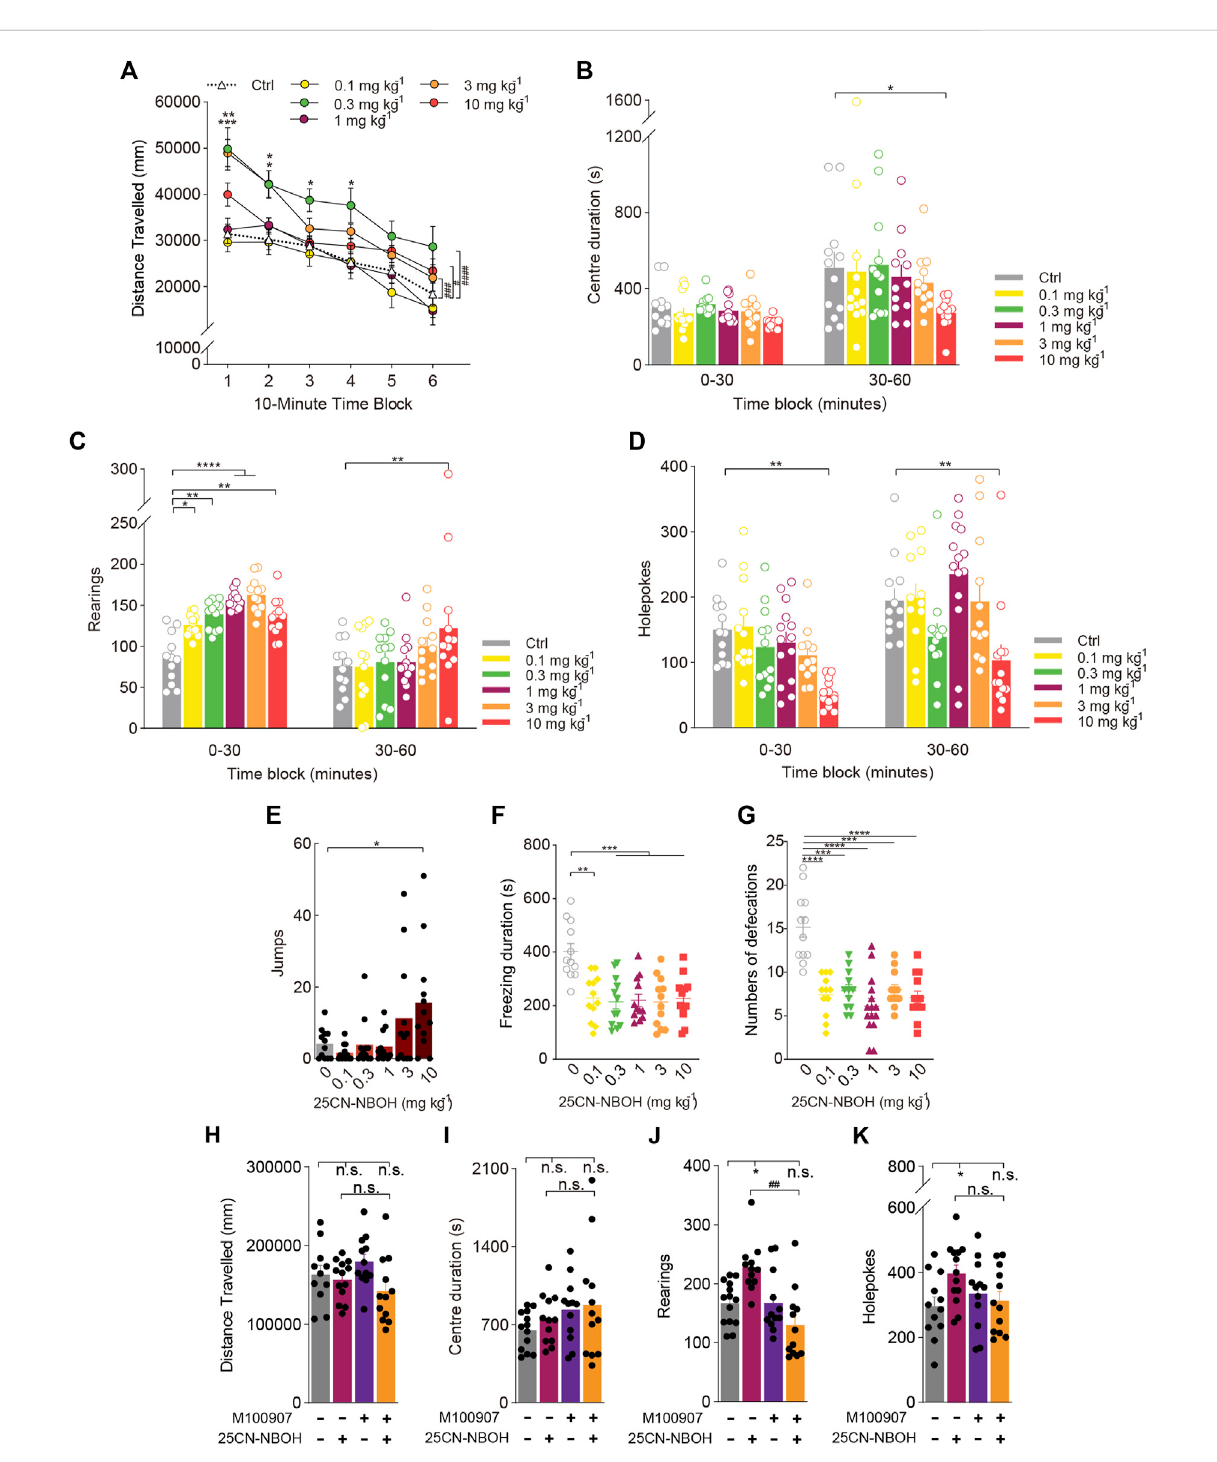
FIGURE 4 Behavioural changes in locomotor and exploratory behaviour of mice induced by the hallucinogenic 5-HT 2A -selective agonist 25CN-NBOH. The effect of 25CN-NBOH on (A,H) distance travelled (in mm), (B,I) centre duration (in seconds), (C,J) the total number of rearing behaviours ( rearings ), (D,K) the total number of hole explorations ( holepokes ), (E) the total number of jumps ( jumps ), (F) freezing duration (in seconds), and (G) the total number of defecations. Data are shown as the means ± SEM for consecutive 10-min (A) and 30-min intervals (B – D) . n = 12 mice per group. Statistical tests included two-way repeated measures (A) , one-way (E – G) , and two-way (A – D) ANOVA followed by Dunnett ’ s multiple comparisons tests comparing treatment groups to the vehicle control group. * p < 0.05, ** p < 0.01, *** p < 0.001, **** p < 0.0001, and # p < 0.05, ### p < 0.001, #### p < 0.0001. (H – K) Effect of pretreatment with the 5-HT 2A antagonist M100907 (1 mg/kg 25CN-NBOH +0.01 mg/kg M100907). n = 12 mice per group. Data were analysed by two-way ANOVA followed by Bonferroni ’ s multiple comparison test. Data are presented as group means ± SEM. * p < 0.05, signi fi cantly different from the control group; ## p < 0.01, signi fi cantly different from mice given 25CN-NBOH alone; n. s., not signi fi